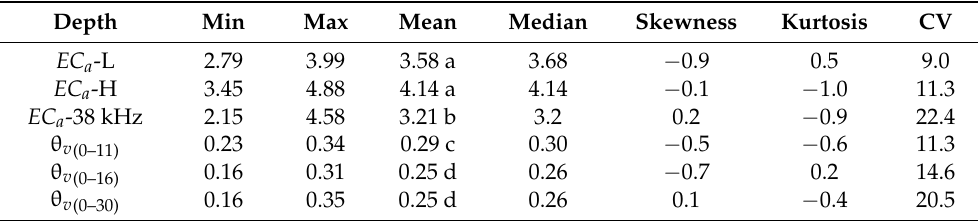
Table 2. Descriptive statistics of the EC a (mS m − 1 ) measurements using CMD-MINIEXPLORER Table 2. : Descriptive statistics of the EC a (mS m − 1 ) measurements using CMD-M INI E XPLORER and